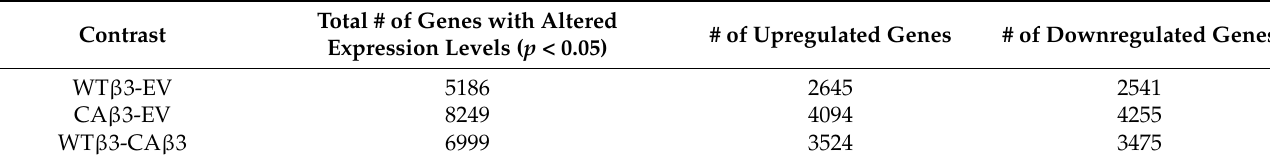
Table 1. Summary of differential gene expression analysis for TM-1 cells overexpressing either a wild type β 3 integrin (WT β 3) or a constitutively active β 3 integrin (CA β 3). Control cells were transduced with an empty vector (EV). These data can be accessed in the supplemental file: edgeRglm_GENE_3 contrasts_low-high_logFC_no NS genes.xlsx. The complete data set has also been deposited in NCBI’s Gene Expression Omnibus and is accessible through GEO Series. Accession number: GSE180407. # = number.